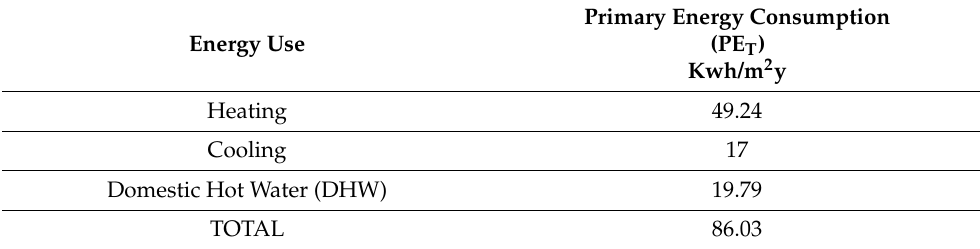
Table 1. Current PE consumption of case study pilot building.